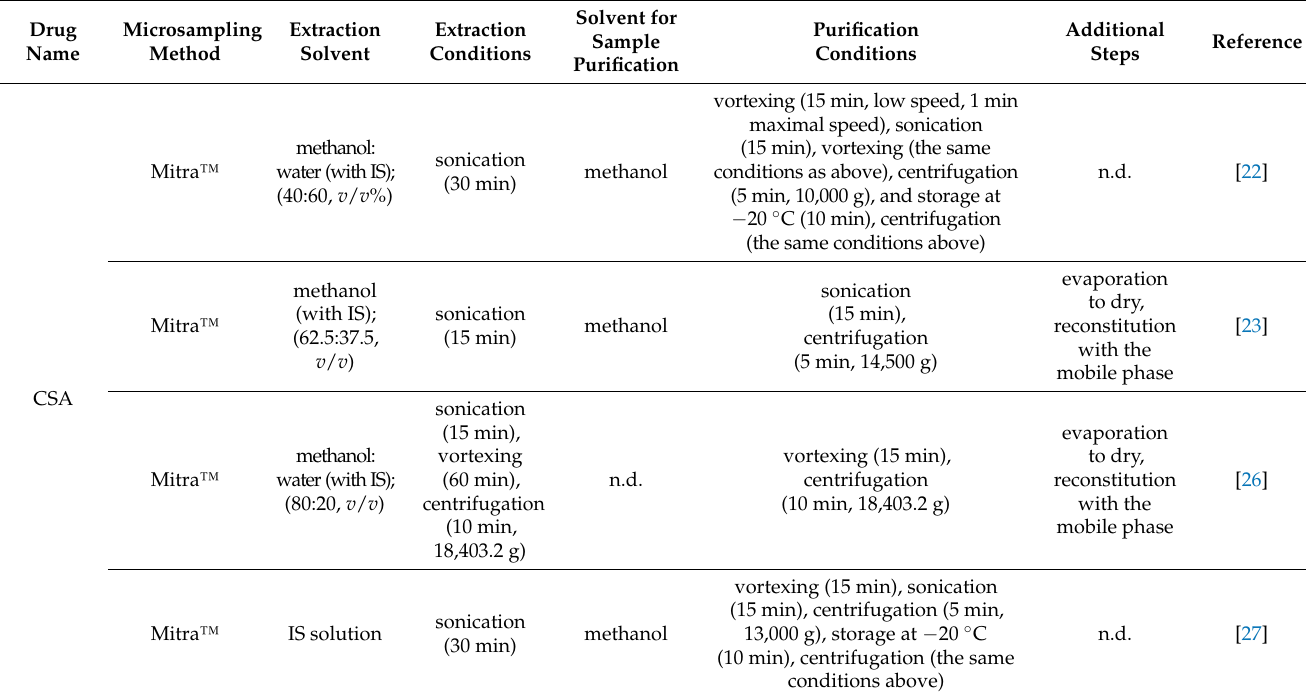
Table 2. Summary of sample preparation characteristics of immunosuppressive drug assays in common with microsampling